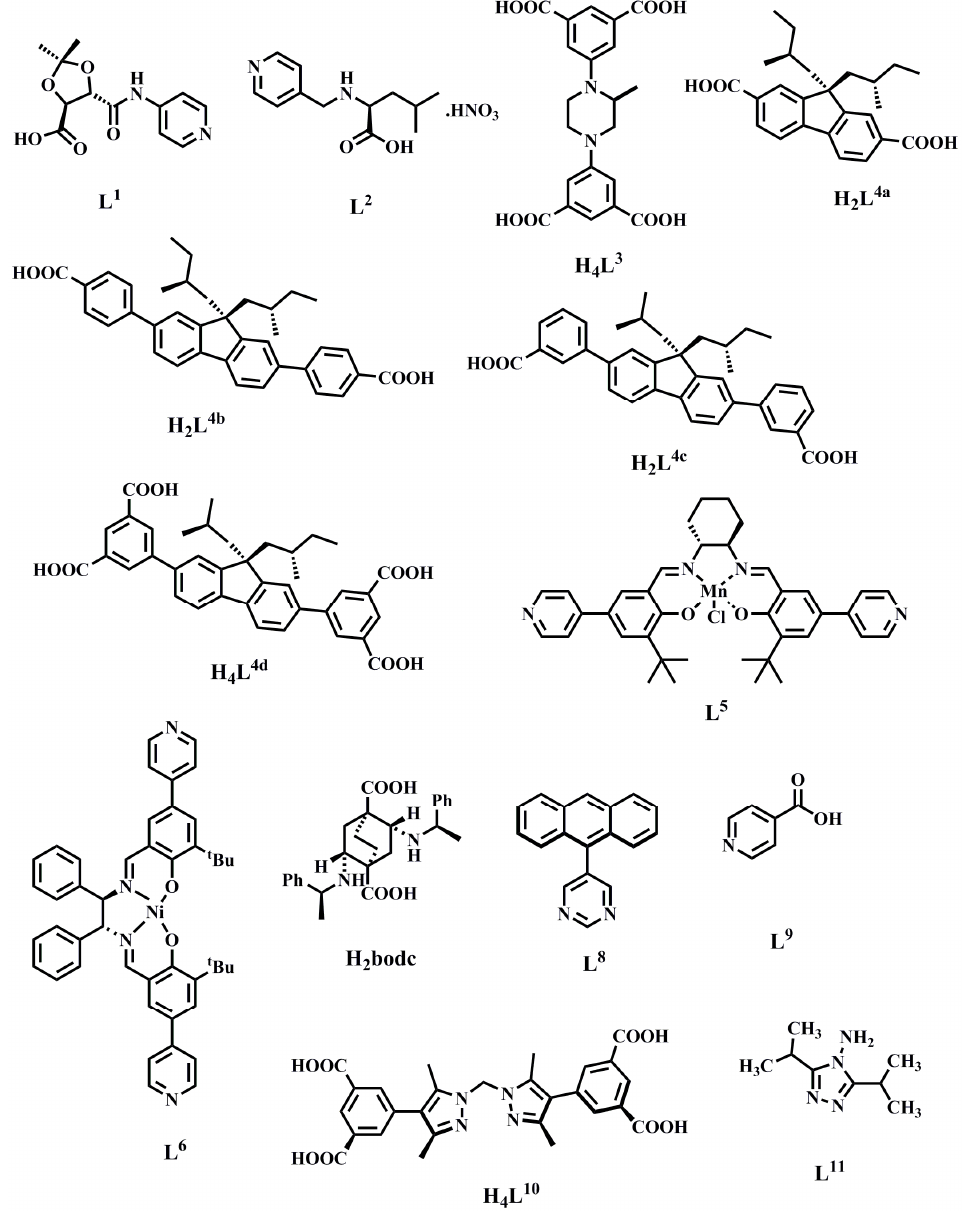
Figure 3. Synthetic procedure of the homochiral MOF ZnW-PYI ( 2 ) and schematic representation of the catalytic synthesis of cyclic-carbonates. Reproduced from [54] with permission from Nature Publishing